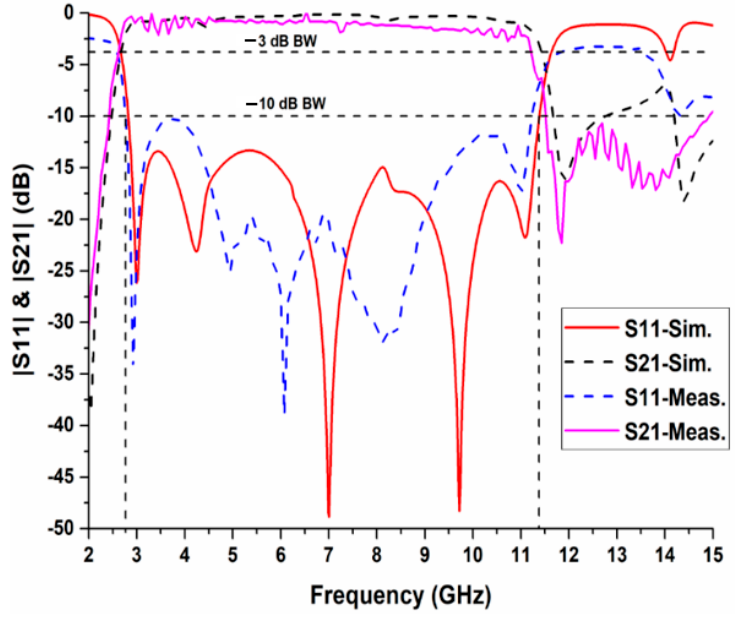
Figure 9. S-Parameters of the fabricated UWB single-wing bandpass filter.